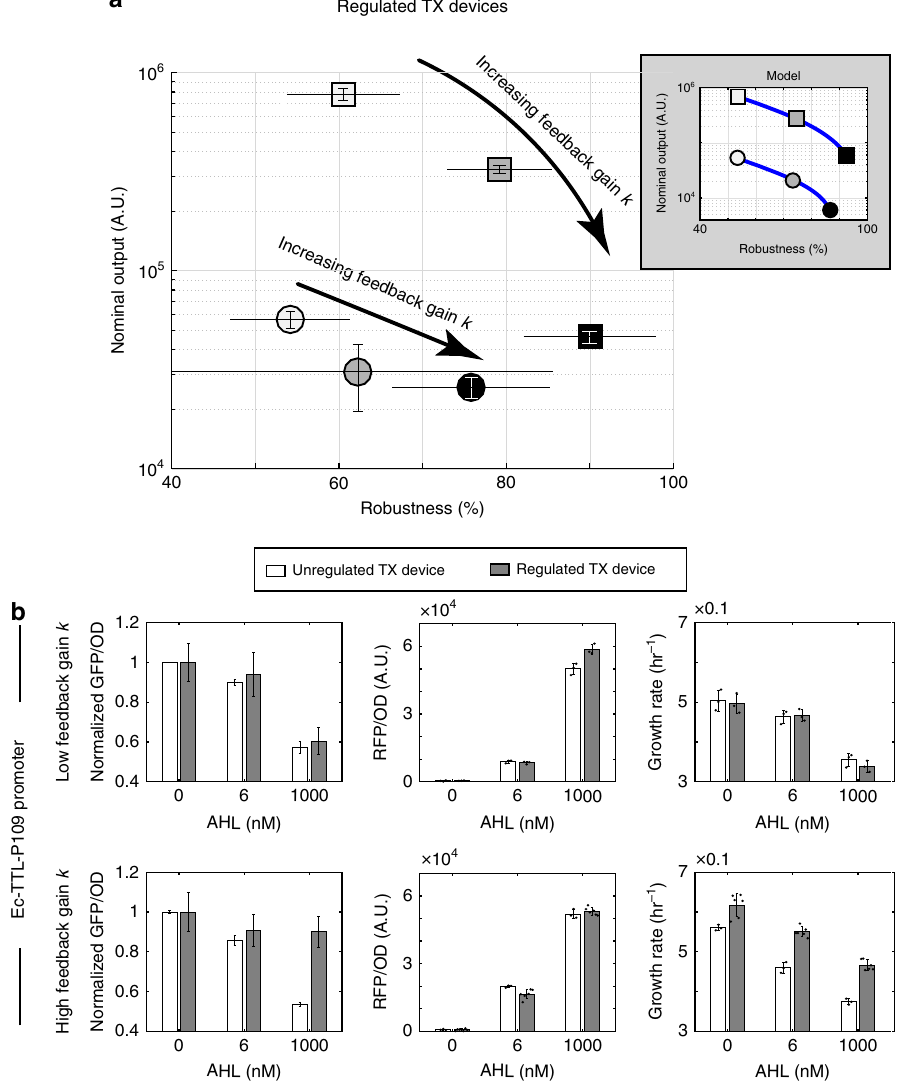
Fig. 5 Performance of a regulated TX device is determined by its feedback gain. a Increasing feedback gain enhances the robustness of a regulated TX device driven by either the stronger Ec-TTL-P109 promoter (a square symbol) or the weaker BBa_J23116 promoter (a circle symbol). A symbol ’ s color fi lling in gray scale from light to dark represents a feedback gain from low to high. Simulation results for model (2) – (4) with parameters in Supplementary Table 9 are in the inset box (see Supplementary Fig. 18 for additional simulation results). b GFP outputs, growth rates, and RFP outputs for low-gain and high-gain regulated and unregulated TX devices using the Ec-TTL-P109 promoter. GFP per OD values in arbitrary unit (A.U.) were normalized to their respective nominal outputs. All experimental data were obtained with a microplate photometer. Data with error bars represent mean values± standard deviations. The regulated TX device using Ec-TLL-P109 promoter and high feedback gain has six replicates (three biological replicates each with two technical replicates). Other TX devices have three biological replicates. Speci fi c value of an independent experiment is presented as a black dot. See Supplementary Fig. 10 for data for TX devices using BBa_J23116 promoter and/or medium feedback gain. Supplementary Figs. 7 and 8 contain complete temporal responses of all 12 circuits. Source data are provided as a Source Data fi le.Source